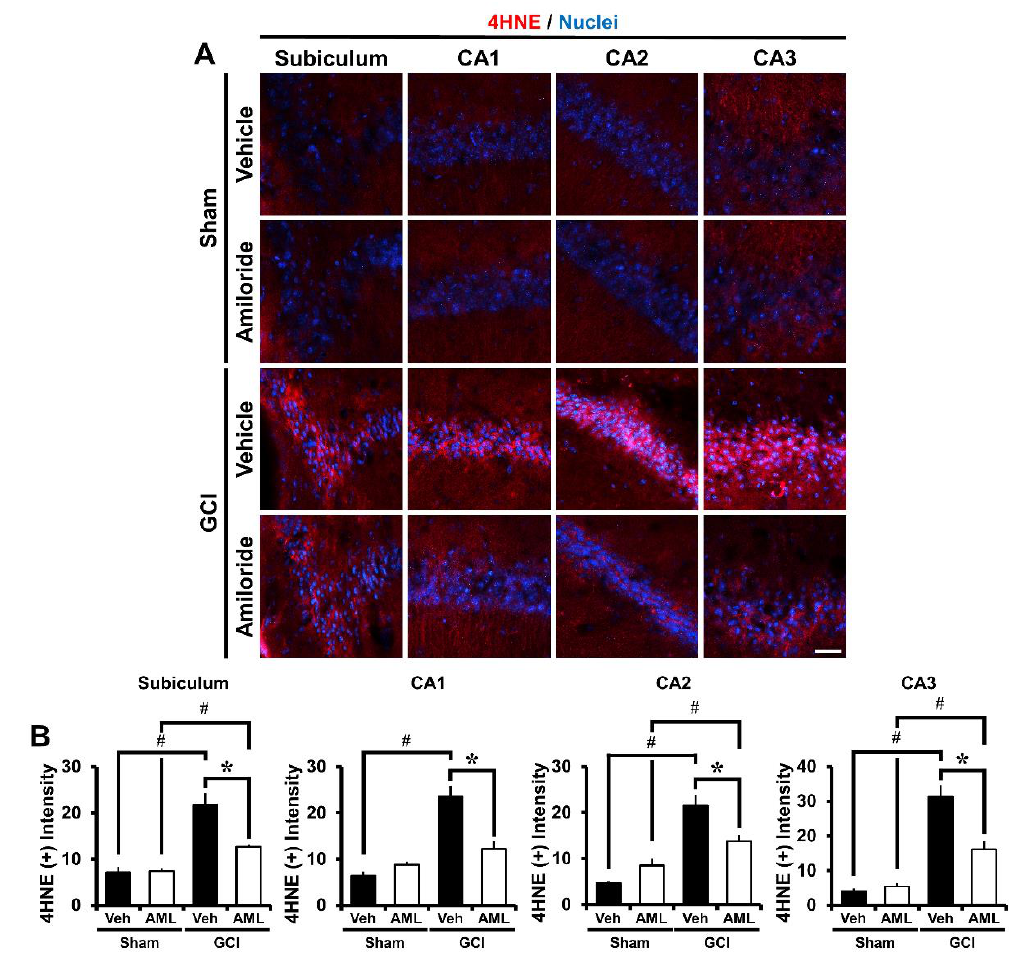
Figure 3. Amiloride reduced oxidative injury after GCI. Oxidative injury was detected by 4-hydroxynonenal (4HNE, red color) staining from the hippocampal Sub, CA1, CA2, and CA3 regions 24 h after GCI. ( A ) Sham-operated groups showed minimal 4HNE fluorescence signals in the hippocampus. Amiloride-treated groups showed reduced immunoreactive fluorescence intensity for 4HNE in the hippocampus compared with the vehicle-treated group after GCI. Scale bar = 20 μm. ( B ) The bar graph presents the 4HNE fluorescence intensity in the Sub, CA1, CA2, and CA3 regions. The fluorescence intensity showed a significant difference among groups (sham-vehicle, n = 6; sham-amiloride, n = 5; GCI-vehicle, n = 8; GCI-amiloride, n = 8). Data are mean ± S.E.M. * Considerably different from the vehicle-treated group, p < 0.05; # sham versus vehicle-operated group, sham versus vehicle-treated group, p < 0.05. (Kruskal–Wallis test (B) Sub: Chi square = 22.444, df = 3, p < 0.001; CA1: Chi square = 17.896, df = 3, p < 0.001; CA2: Chi square = 20.967, df = 3, p < 0.001; CA3: Chi square = 20.986, df = 3, p < 0.001).